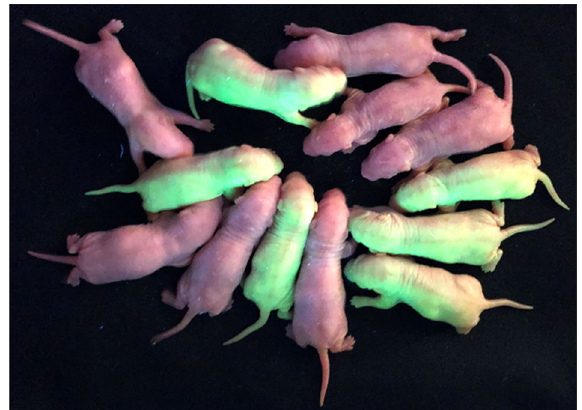
Figure 6. Live pups derived from in vitro fertilisation using cold-transported rat sperm. Fertilised oocytes were transferred into the oviducts of pseudo-pregnant female rats. The embryos developed normally into live pups 22–23 days after embryo transfer. Wild type and GFP-positive pups are